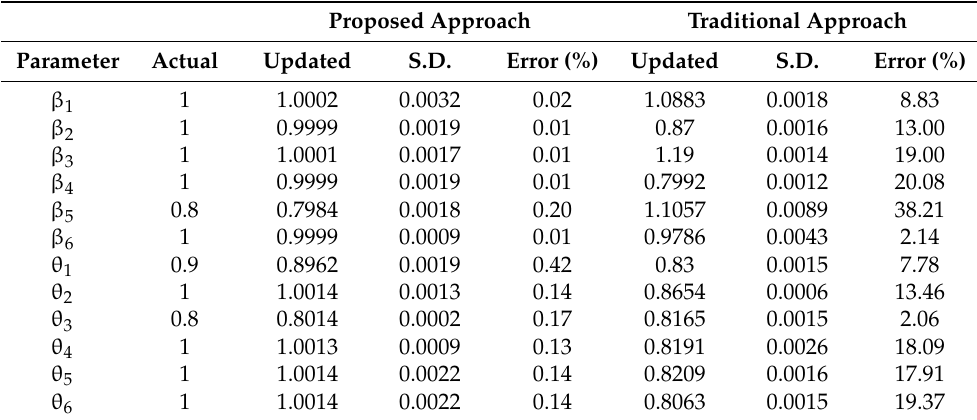
Table 5. Results of updated structural parameters for damage case No.1. Proposed